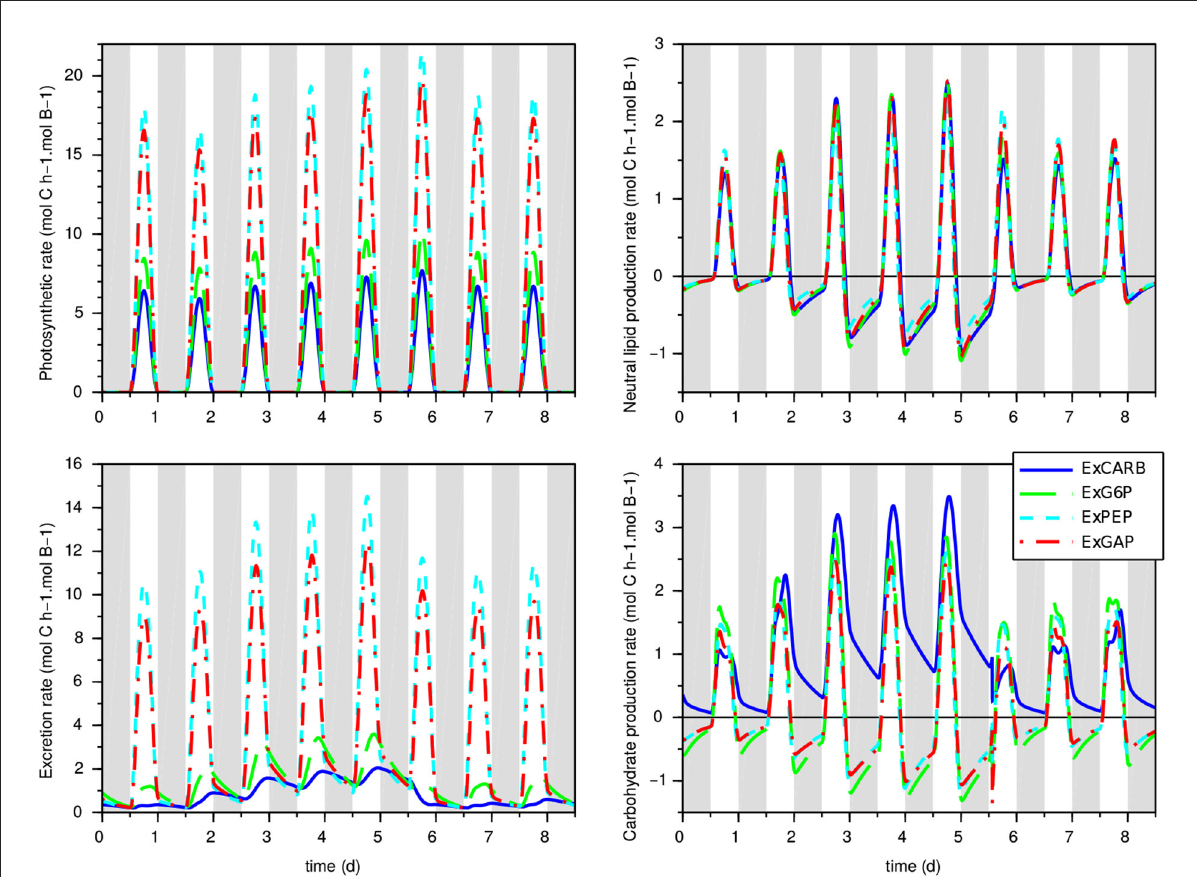
FIGURE4 Prediction of carbon flux rates for the models with excretion in the calibration experiment. Top left: photosynthetic rate; bottom left: excretion rate; top right: neutral lipid production; bottom right: carbohydrate production. Gray bands represent night